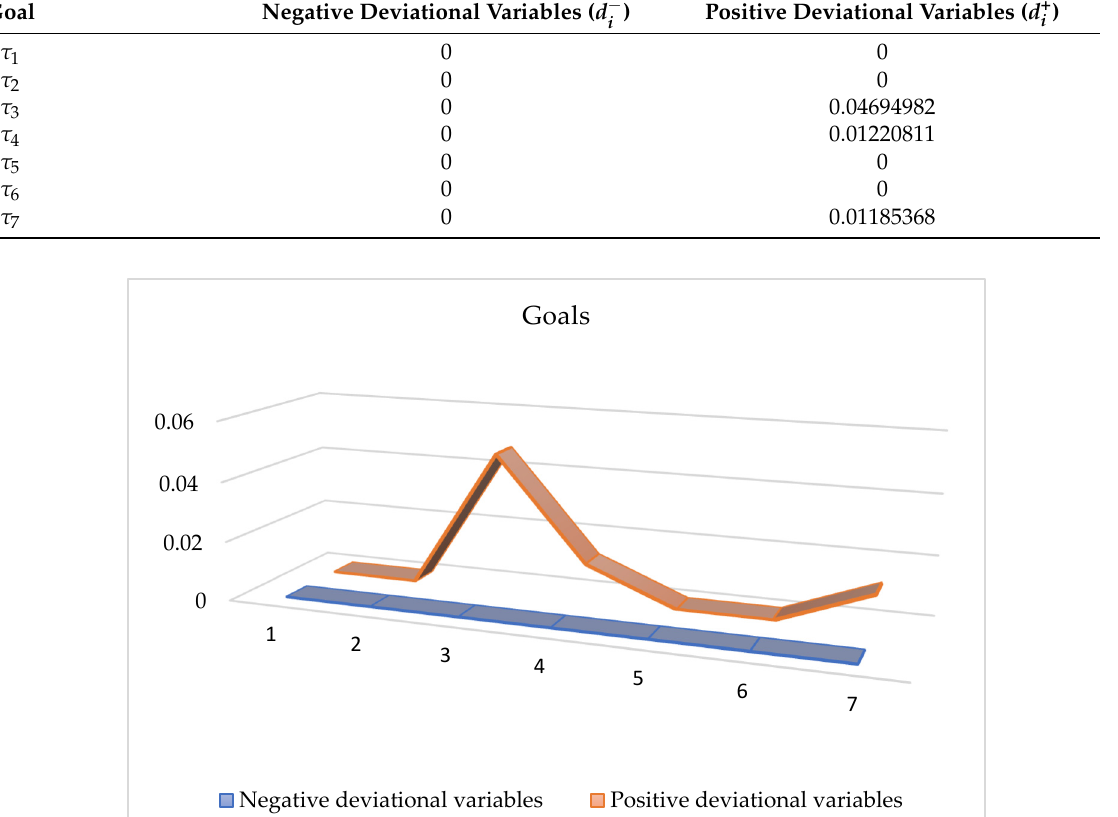
Figure 1. Outcomes of deviational variables.